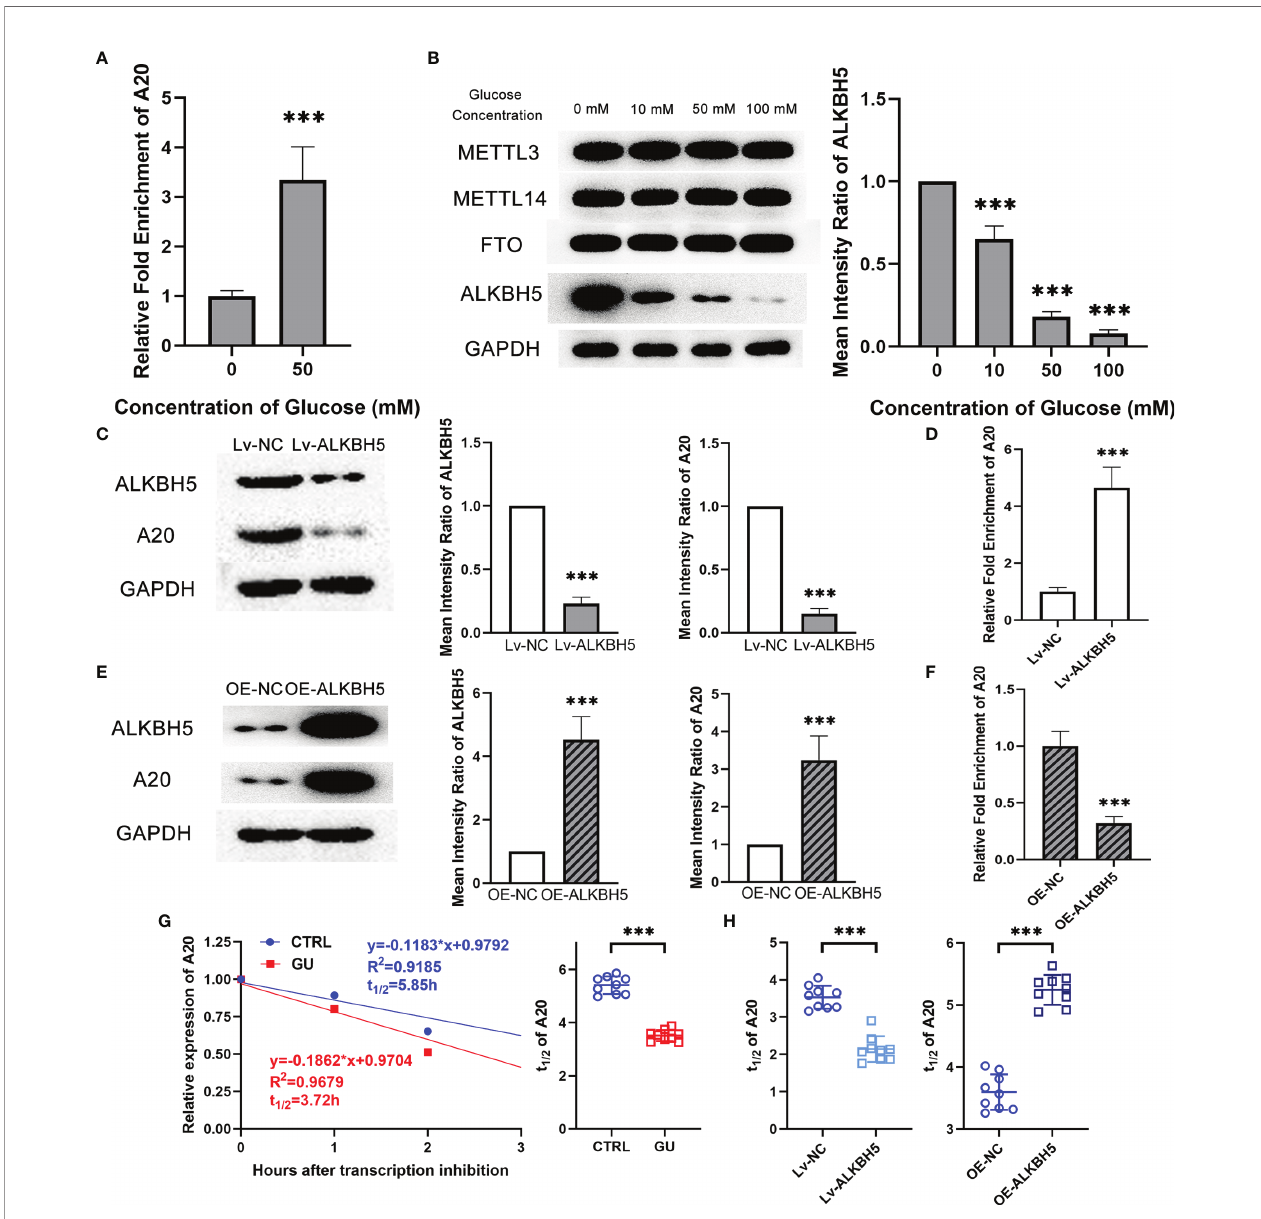
FIGURE 6 | Decreasing ALKBH5 led to lower A20 expression through m 6 A modi fi cation in microglia with glucose stimulation. (A) The m 6 A modi fi cation level of A20 was higher in the glucose treatment group than in the control group. (B) ALKBH5 expression at protein level decreased with glucose treatment. The expression of METTL3, METTL14 and FTO kept unchanged. (C) Lv-ALKBH5 signi fi cantly inhibited the expression of both ALKBH5 and A20. (D) The m 6 A modi fi cation level of A20 was higher in the Lv-ALKBH5 group than in the Lv-NC group. (E) OE-ALKBH5 signi fi cantly promoted the expression of both ALKBH5 and A20. (F) The m 6 A modi fi cation level of A20 was lower in the OE-ALKBH5 group than in the OE-NC group. (G) The degradation rate of A20 mRNA shown by t 1/2 value was higher in the glucose treatment group than in the control group. (H) Lv-ALKBH5 decreased the t 1/2 value, and OE-ALKBH5 increased the t 1/2 value of A20 mRNA. Values are presented as the mean ± SD. *** indicates P <